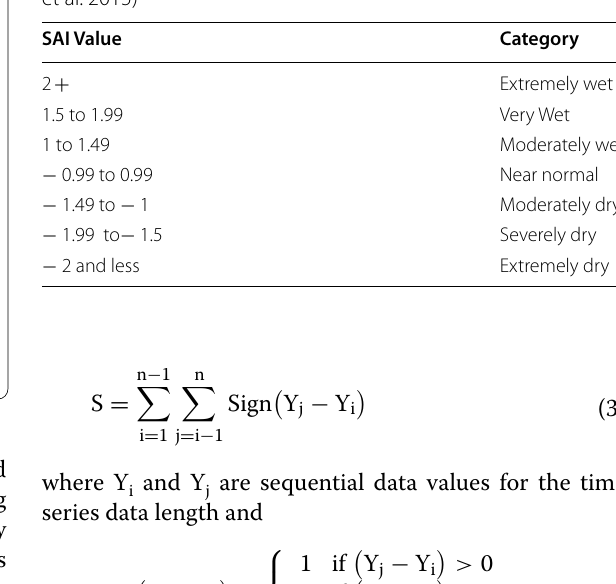
Table 1 Standardized Anomaly Index Value interpretation